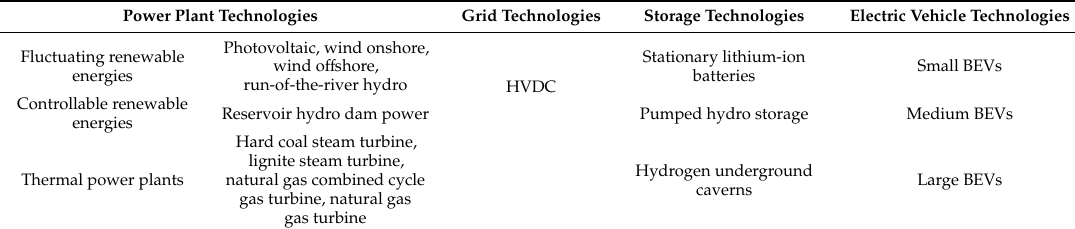
Table 3. Technology resolution of power plant, grid, storage, and EV technologies in REMix. Rows are not related to each